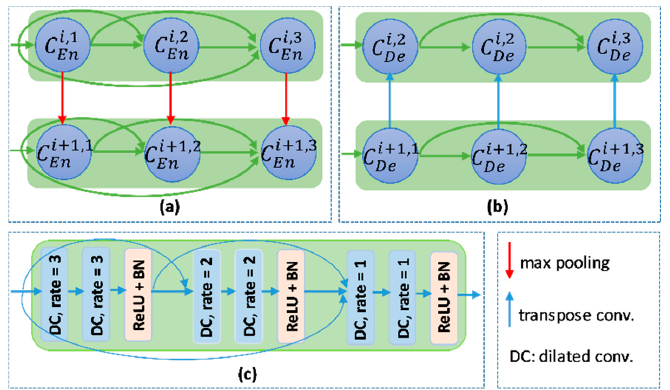
Figure 3. The connection between two nodes in ( a ) the encoder part and ( b ) the decoder part. ( c ) the detail of the encoder node.